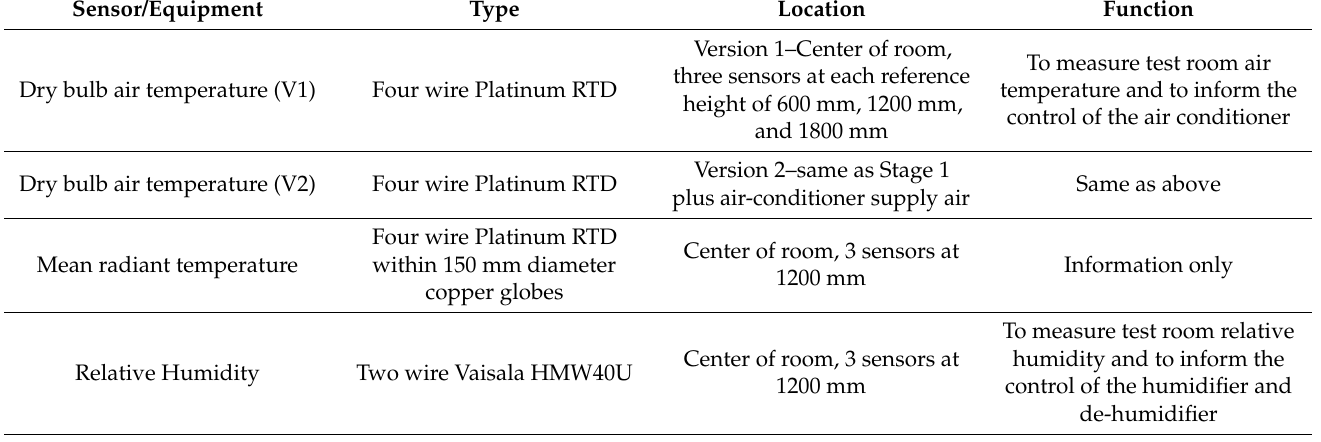
Figure 9. Air-conditioner.